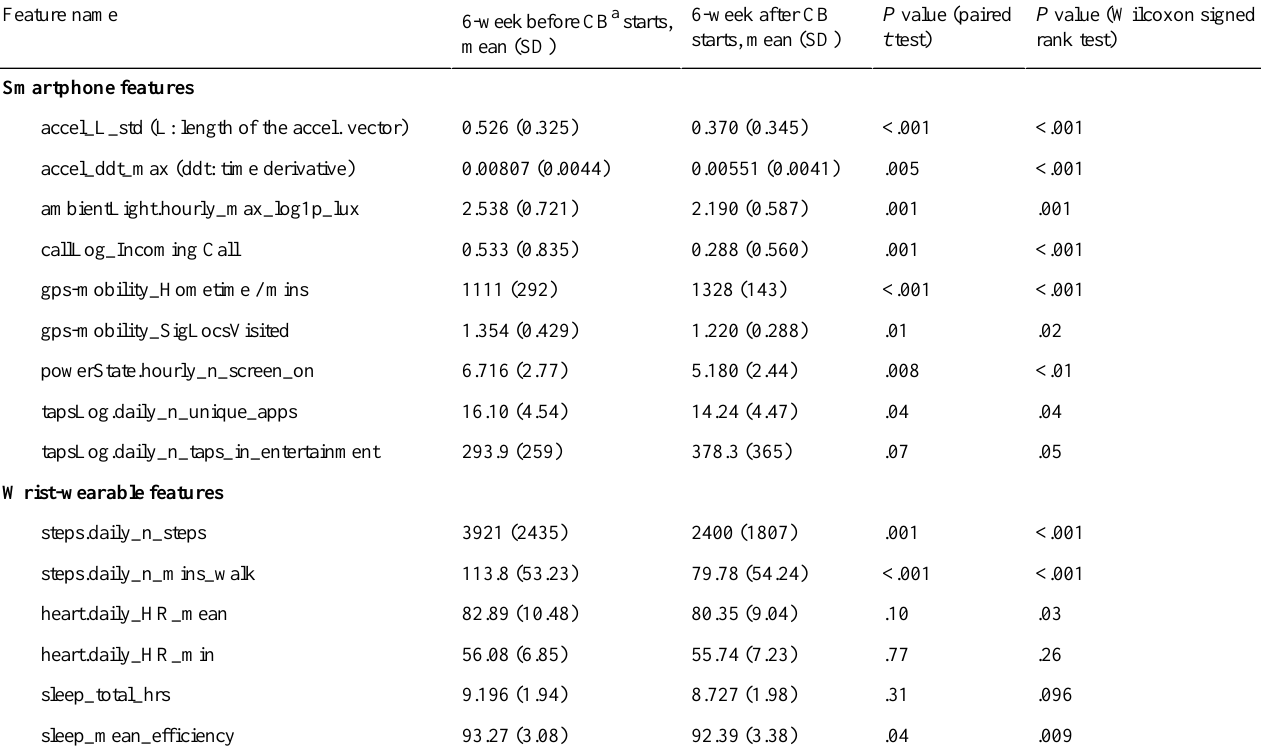
Table 2. Comparison of 6 weeks of digital phenotyping data before (from 45 days before to 3 days before) and after (from 3 days after to 45 days after) the start of Singapore’s Circuit Breaker on April 7,